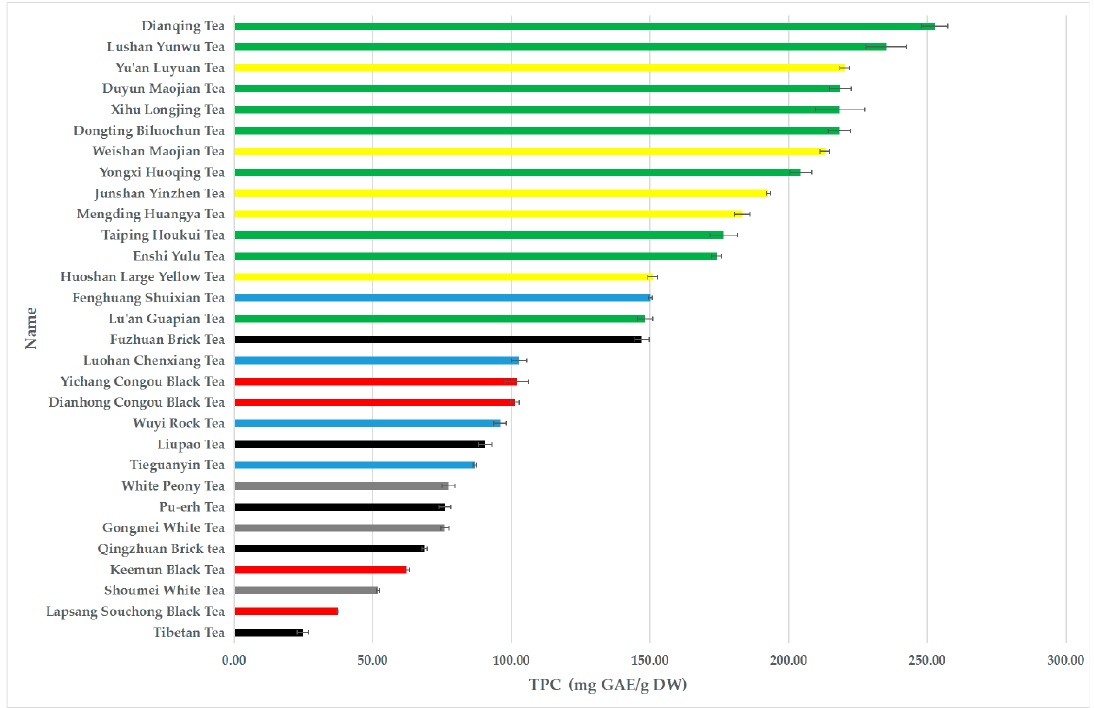
Figure 3. The TPC values of 30 teas.